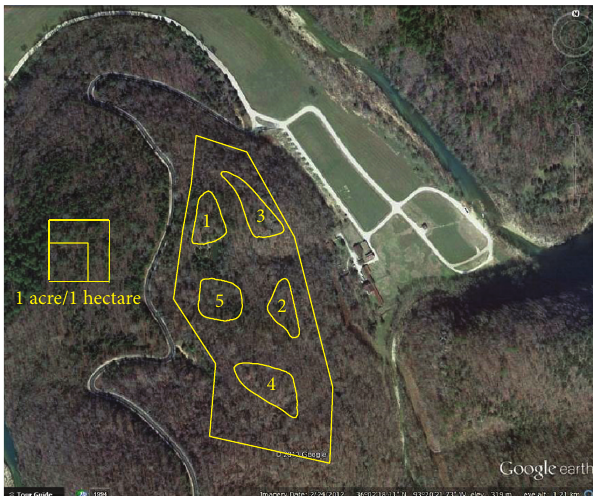
Figure 2: Overhead view of the field site at Steel Creek, with approximate limits of the site and blocks and acre/hectare scales in yellow. Base image taken from Google Earth [29].